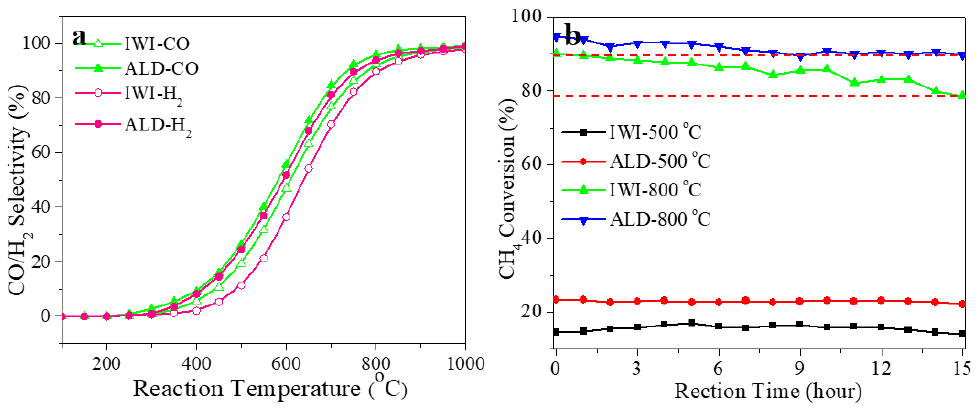
Figure 7. ( a ) CO and H 2 selectivity of Rh/ γ -Al 2 O 3 catalysts from IWI and ALD between 100–1000 °C; ( b ) CH 4 conversion of Rh/ γ -Al 2 O 3 catalysts from IWI and ALD over 15 h under 500 and 800 °C.